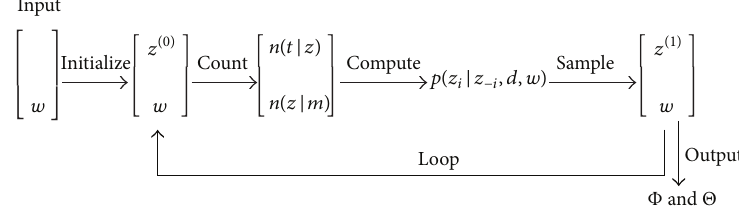
Figure 2: A brief illustration of Gibbs sampling process.